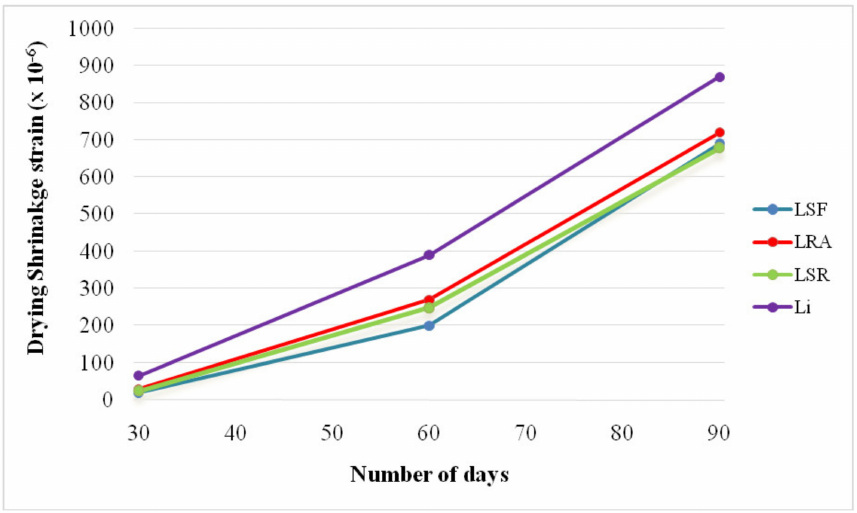
Figure 10. Drying shrinkage of lime and lime composite